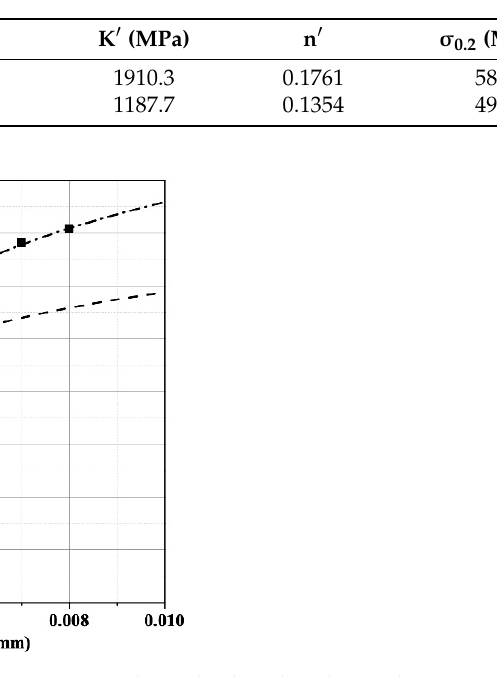
Figure 5. Simulation results of the cyclic stress—strain relationship based on the Ramberg–Osgood model.